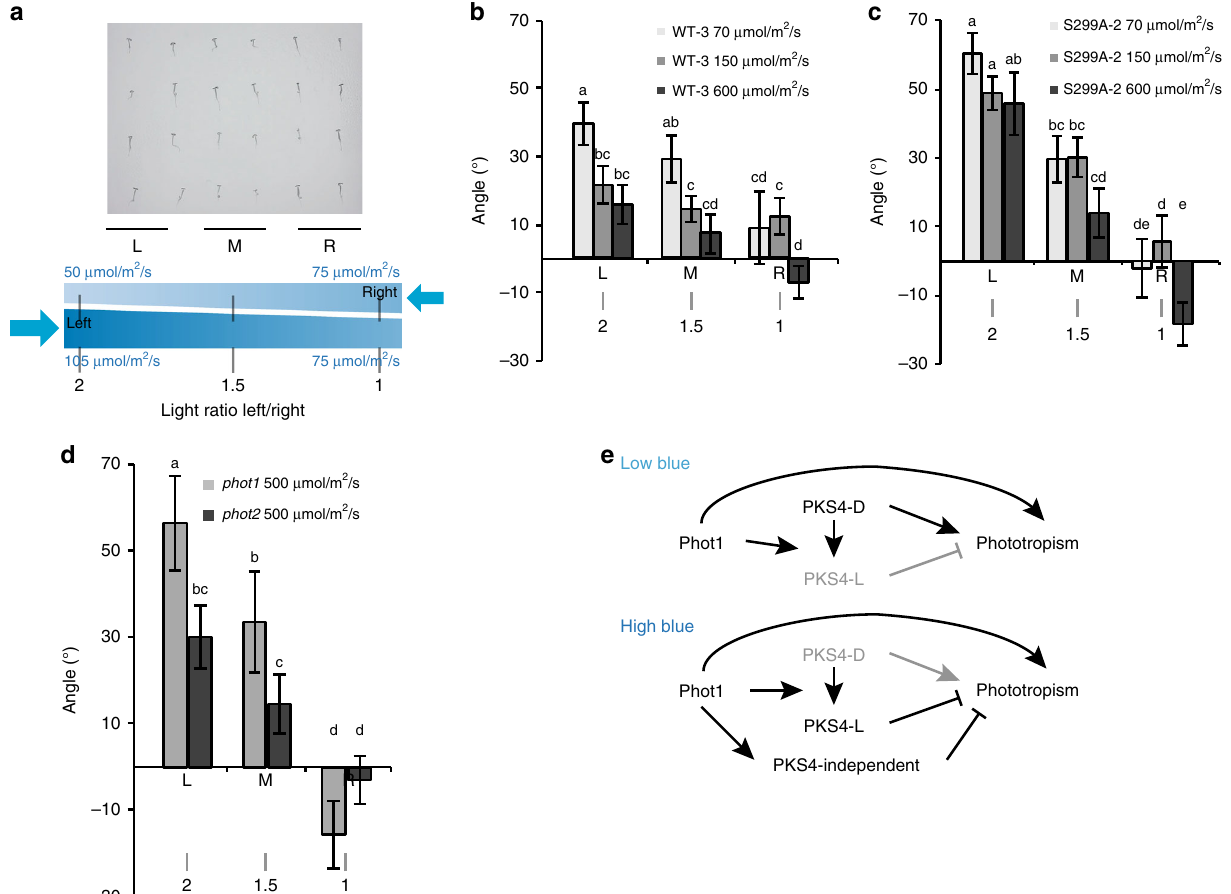
Fig. 4 phot1 and S299 are needed for a normal response to light gradients. a Graphic representation of the experimental setup. Blue numbers on top represent blue light intensity coming from the right on the left and right side of the plate. Blue numbers on the bottom represent blue light intensity coming from the left on the left and right side of the plate. Black numbers represent the light ratio between the left and right sides. L, M, and R represent two columns of seedlings on the Left, Middle, and Right side of the plate, respectively. Note that seedlings in the L position are exposed to approximately a 2/1 light ratio while those in the R position get about the same intensity from each side. b Phototropic curvature of pks4 PKS4-WT-3 seedlings treated with 400/105/50 µ mol m − 2 s − 1 from the left and 300/75/30 µ mol m − 2 s − 1 from the right. These values maintain the same gradient across the plate at a total light intensity of 600/150/70 µ mol m − 2 s − 1 . n = 82 − 91. c Phototropic curvature of pks4 S299A-2 seedlings treated as in panel ( b ). n = 82 − 91. d Phototropic curvature of phot1 and phot2 seedlings treated with 360 µ mol m − 2 s − 1 from the left and 240 µ mol m − 2 s − 1 from the right (500 µ mol m − 2 s − 1 total light), maintaining the same gradient across the plate as in ( b , c ) at a high overall intensity. n = 15 − 26. Seedlings were grown as in Fig. 3. Data represent means of phototropic bending measured after 7 h of light treatment. Error bars represent 2× standard error. Means with same letter are not signi fi cantly different ( p > 0.05, two-way ANOVA test). Positive values correspond to bending towards the left of the plate, negative values correspond to bending towards the right of the plate. e Simpli fi ed model for the role of PKS4 which is enhancing phototropism in low blue light, while inhibiting phototropism in high blue light following phot1-mediated phosphorylation. The inhibitory action of PKS4-L could be through inhibition of phot2-mediated phototropism, a possibility that we have not explicitly included in the model for